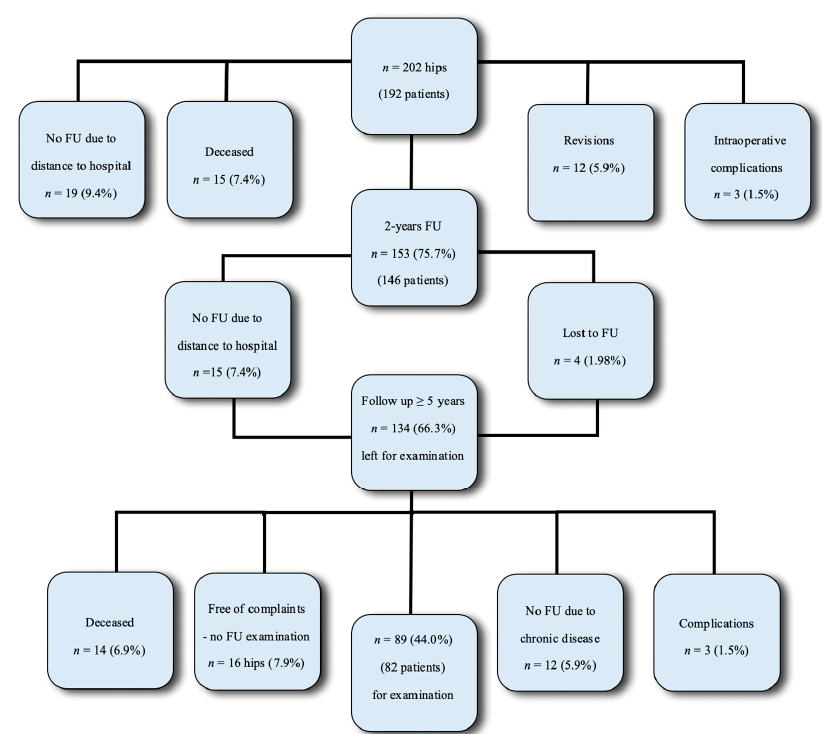
Figure 1. Overview of the follow-up (FU)